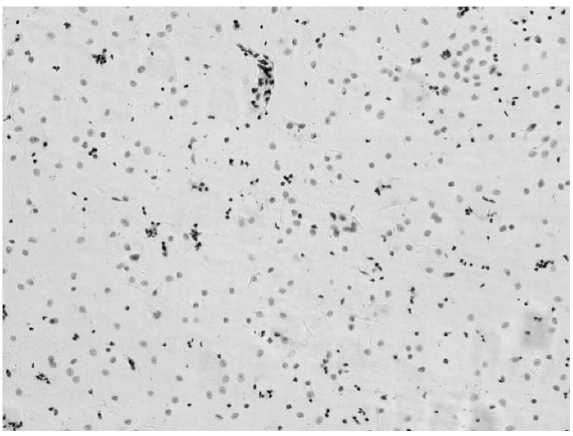
Figure 4. The image after absorbance unmixing. Figure 5 is the pseudo-color image synthesized by using the original images of lights with the wavelengths of 620 nm, 520 nm and 460 nm. Through first collecting the image’s gray value of each direct light source (no slide), the pseudo-color image could be